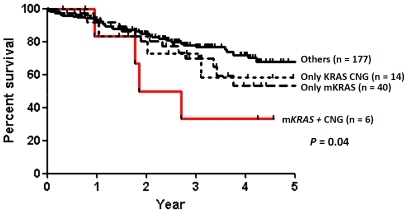
The effect of KRAS mutations and copy number gain (CNG) on clinical outcome in 237 lung adenocarcinomas.The effect of 1) KRAS mutations (without CNG), 2) KRAS CNG (without mutations), 3) both KRAS mutations and CNG, and 4) others (without KRAS mutations and CNGs) on clinical outcome is shown. Tumors having both alterations indicate worse prognosis with borderline significance than all others (P = 0.04). The prefix m- means mutant.